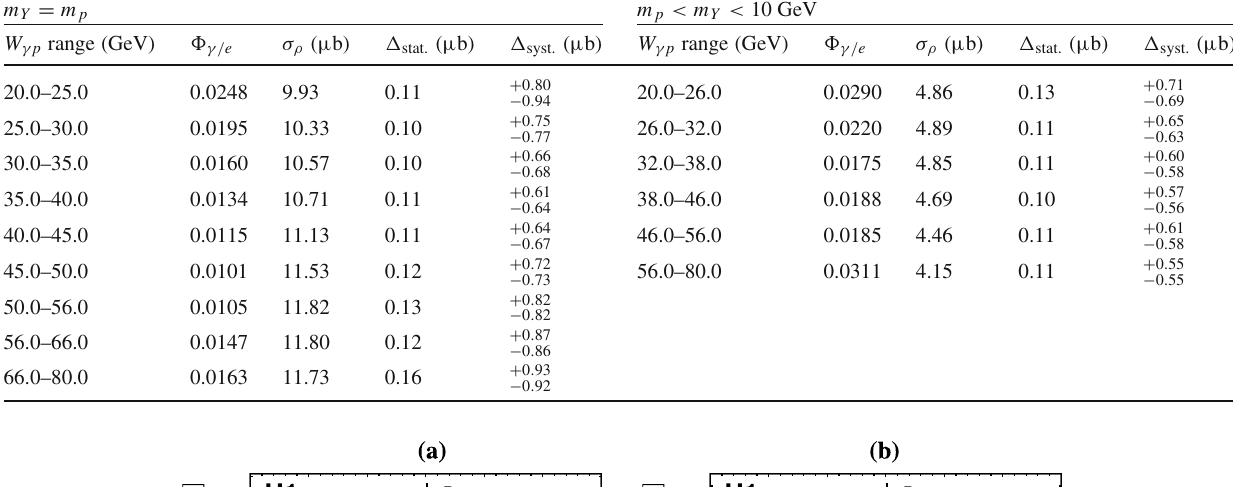
Table7 Elastic( m Y = m p )andproton-dissociative( m p < m Y < 10GeV) ρ 0 meson photoproduction cross sections σ(γ p → ρ 0 Y ) in bins of W γ p . The cross sections are obtained by analysing the π + π − photo- production cross sections given in Tables 18 and 19 with the fit model defined in Eq. (18). The effective photon flux factors (cid:14) γ/ e for each W γ p